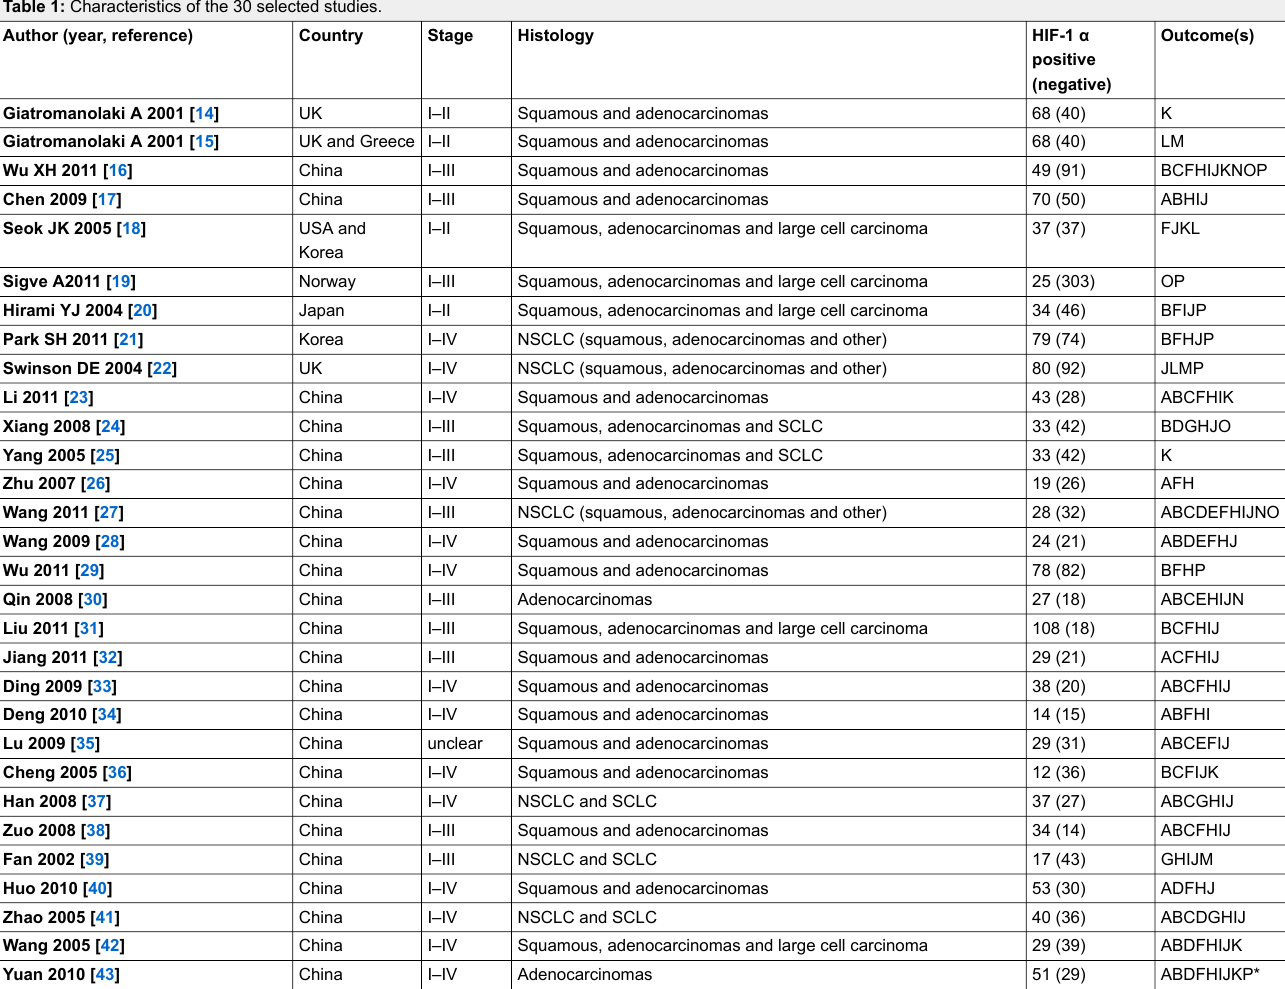
Table 1: Characteristics of the 30 selected